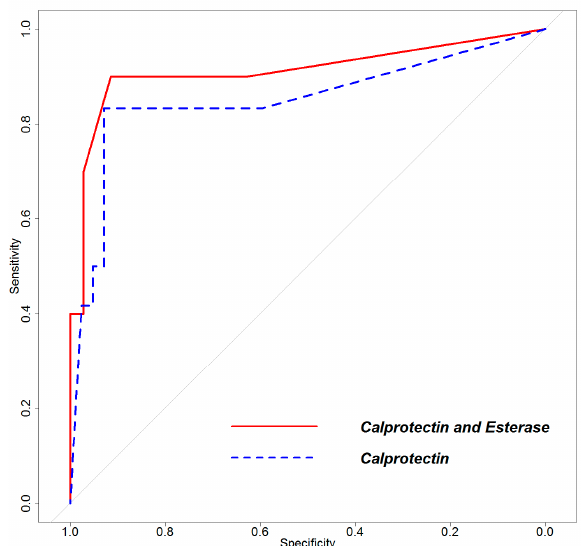
Figure 4. ROC curves obtained by combining the calprotectin and esterase tests or by using the calprotectin test alone.